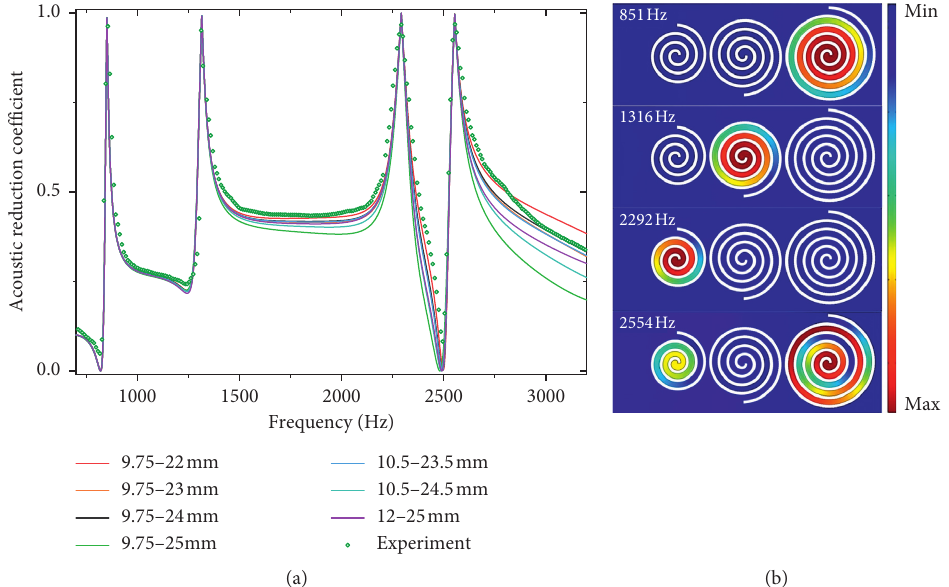
2 and h 3 and comparison with the experimental data for